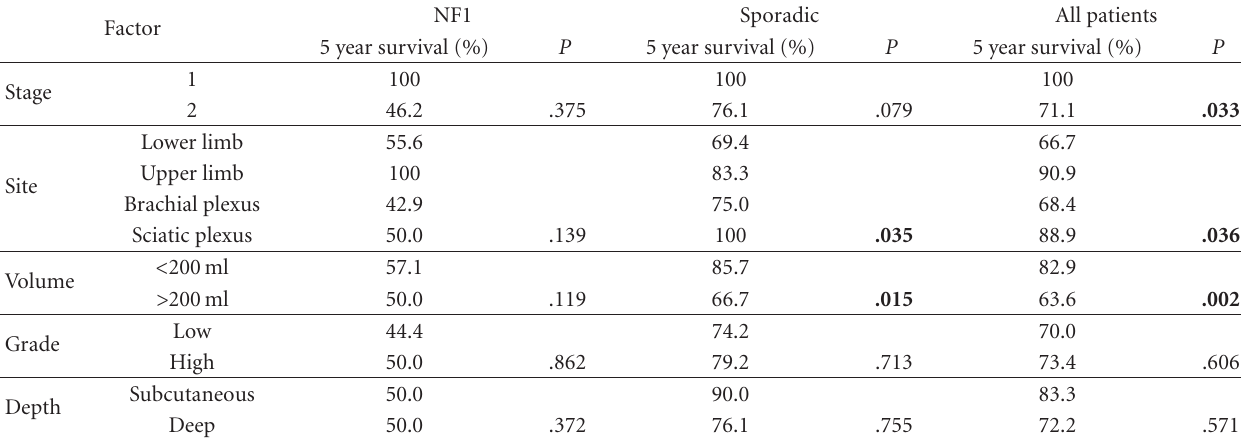
Table 1: Univariate analysis to determine factors significant for survival in patients without metastases at diagnosis.